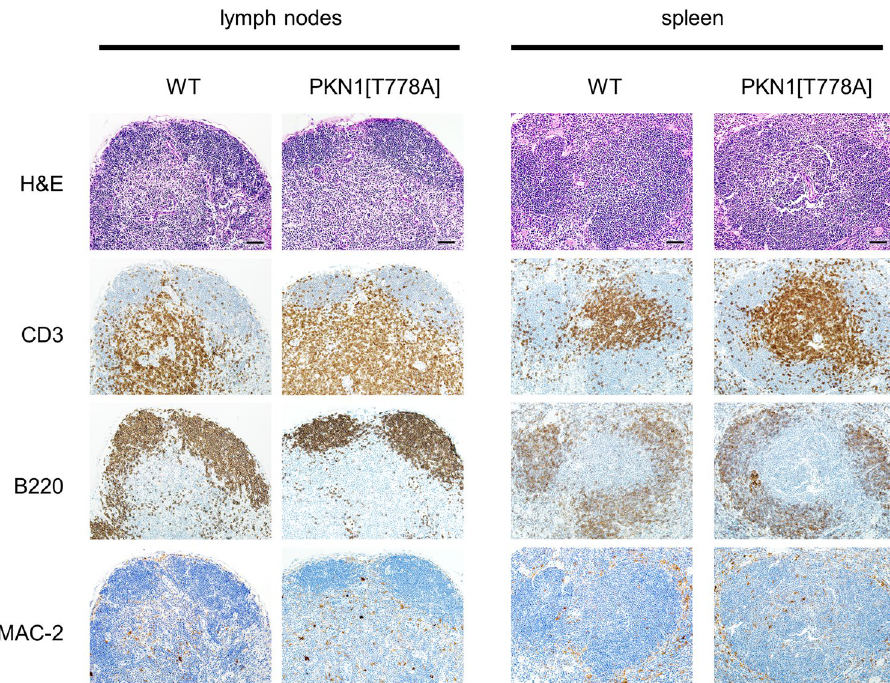
Figure 4. Histological analysis of secondary lymphoid organs. Representative observation from samples of lymph nodes and spleens of 9-week-old mice are shown. H&E, hematoxylin & eosin (H&E) staining; CD3, immunostaining for CD3; B220, immunostaining for B220/CD45R; MAC-2, immunostaining for MAC-2/ Galectin-3. Scale bar: 50 μ